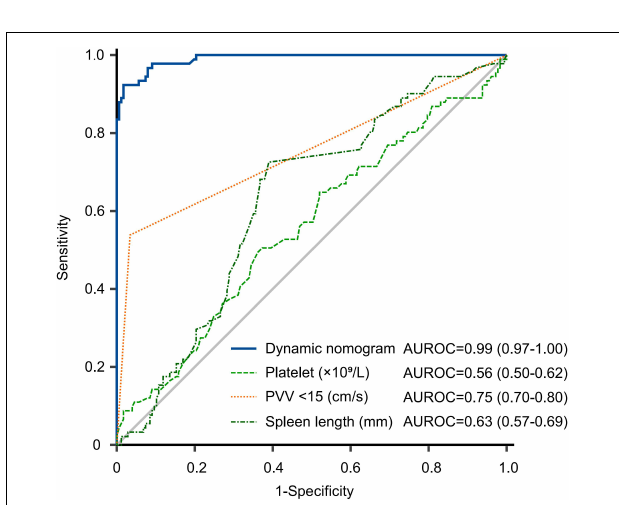
FIGURE 5 | Receiver operating characteristic curve of nomogram and other factors for predicting PVT in the whole cohort. The predictive performance of the dynamic nomogram was comprartively better than platelet, PVV < 15 cm/s and spleen length. AUROC, area under receiver operating characteristic curve; PVV, portal vein